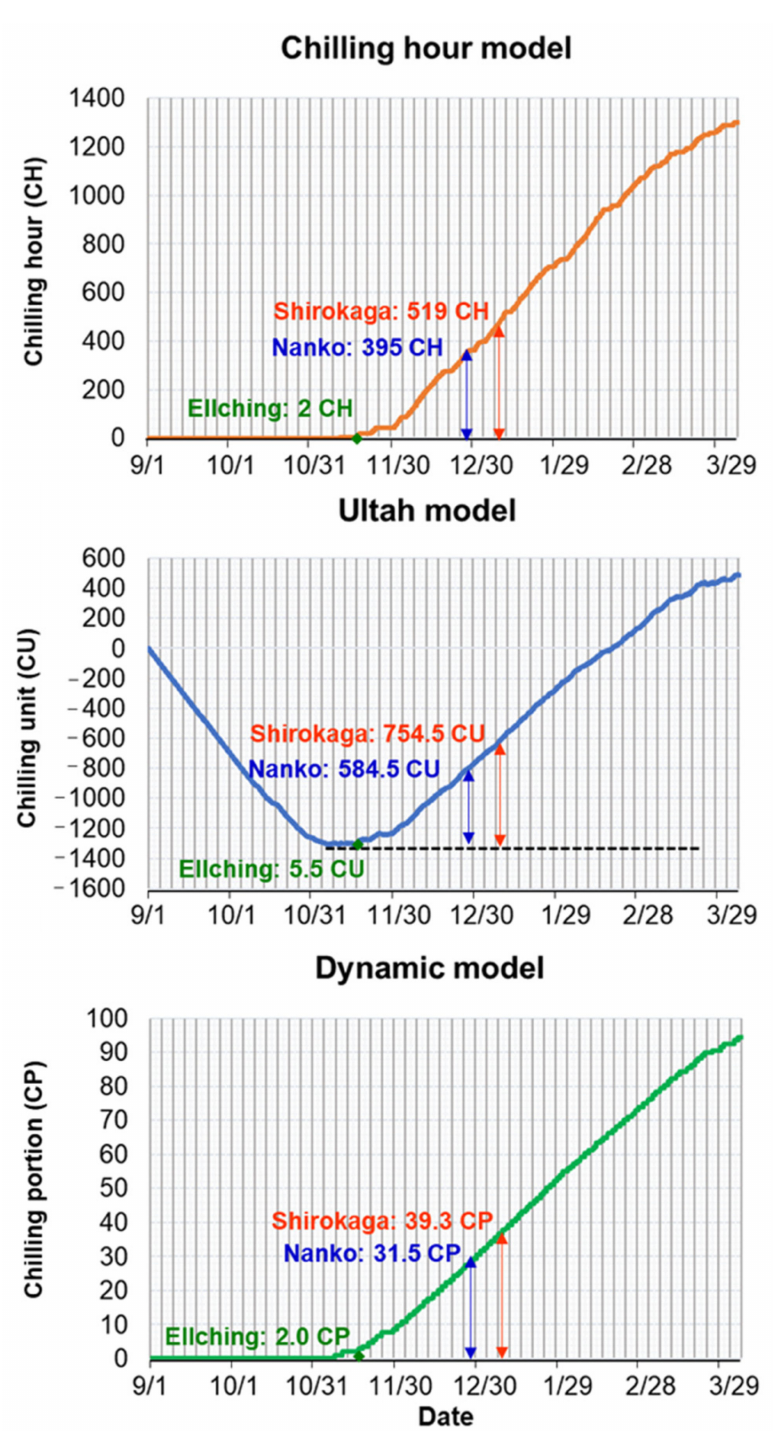
Figure 3. Estimation of the CR of three cultivars using the chilling hour model (top), the chill unit (Utah) model (middle), and the dynamic model (bottom). ‘Nanko’, high chill; ‘Shirokaga’, extra high chill; ‘Ellching’, low